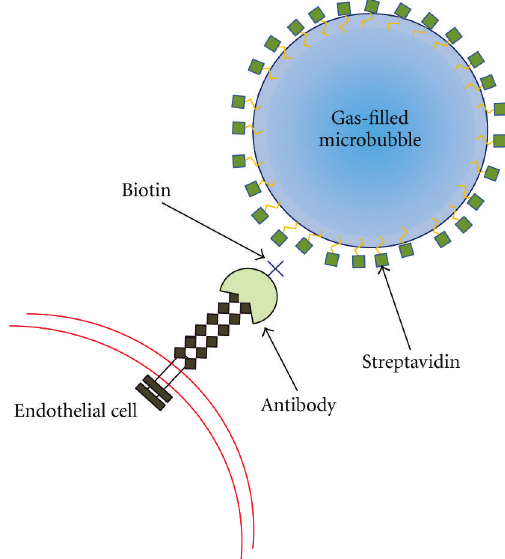
Figure 4: Schematic representation of active targeting of biotin- streptavidine bridges. Streptavidine is used for attachment of biotinylated ligands onto the shell of ultrasound contrast microbub- bles. Molecularly targeted microbubbles selective bind to sites of molecular expression on the